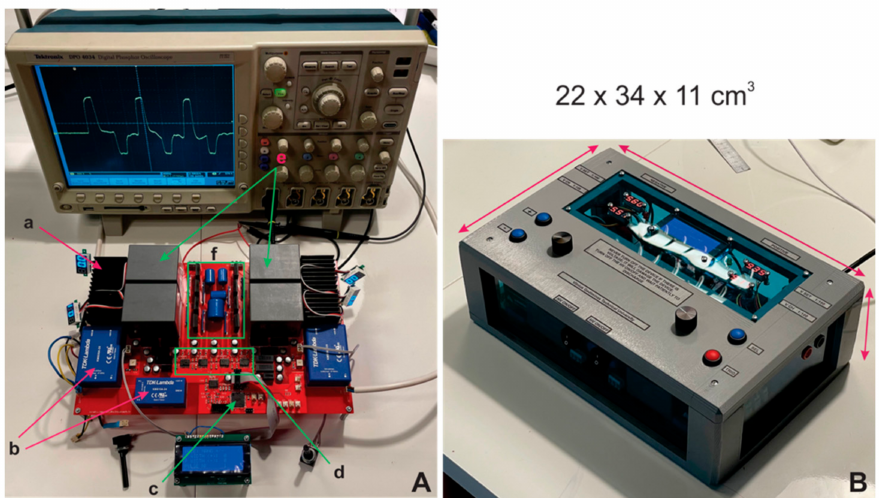
Figure 3. The photograph of the ( A ) electroporator prototype, where a—HV source, b—LV sources with galvanic decoupling, c—microcontroller, d—array of drivers DRV1–4, e—power capacitors, and f—the high-power circuit; ( B ) the final